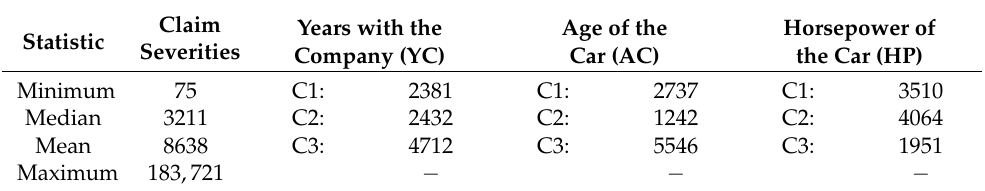
Table 1. Descriptive statistics of claim severities—size of the different categories of the explana- tory